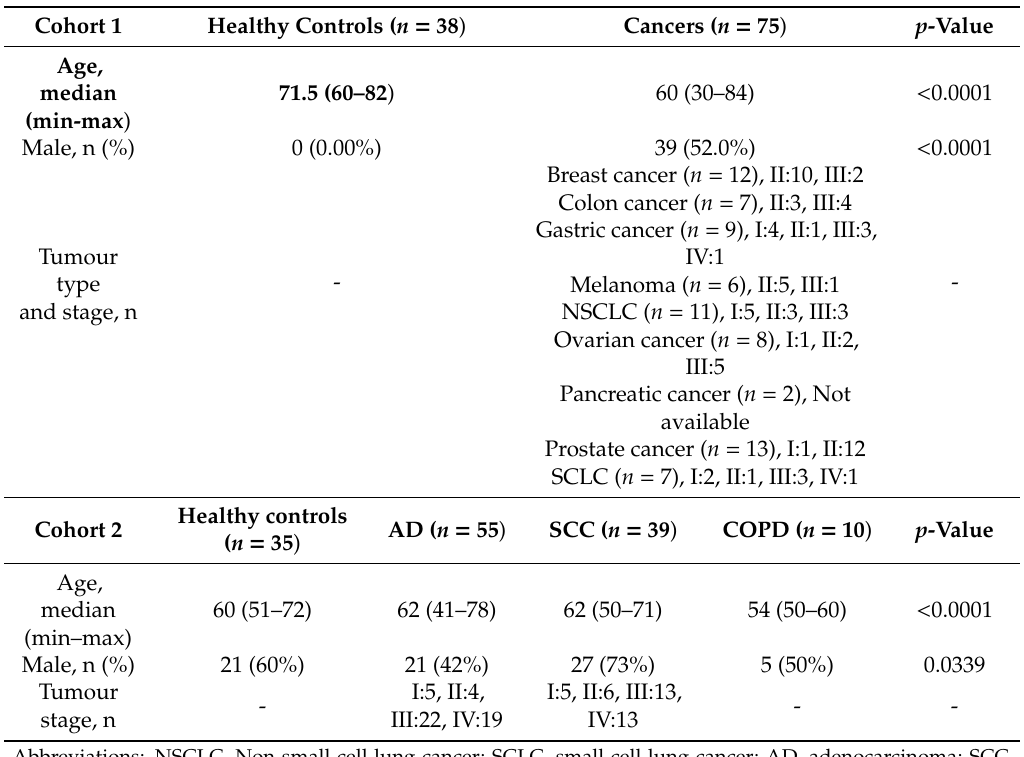
Table 2. Demographics of the